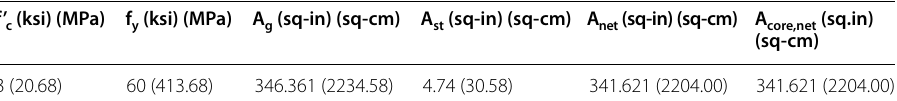
Table 3 Design axial load of RC